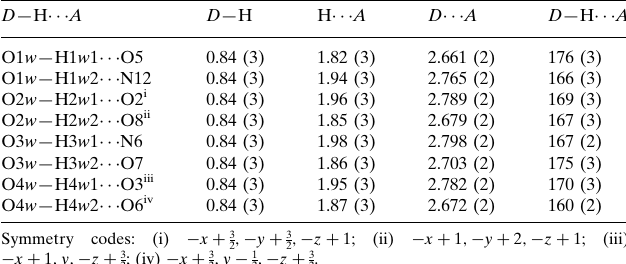
Hydrogen-bond geometry (A˚ , (cid:2)